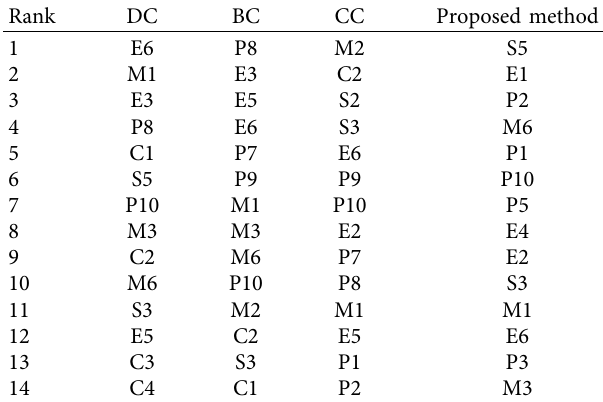
Table 5: The node importance index. Table 6: Top-14 nodes selected by different